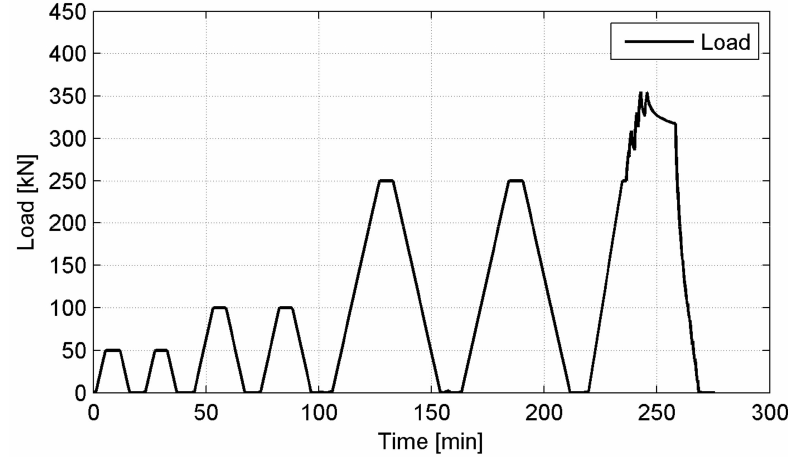
Figure 5. Typical load track for tyre bale compression.